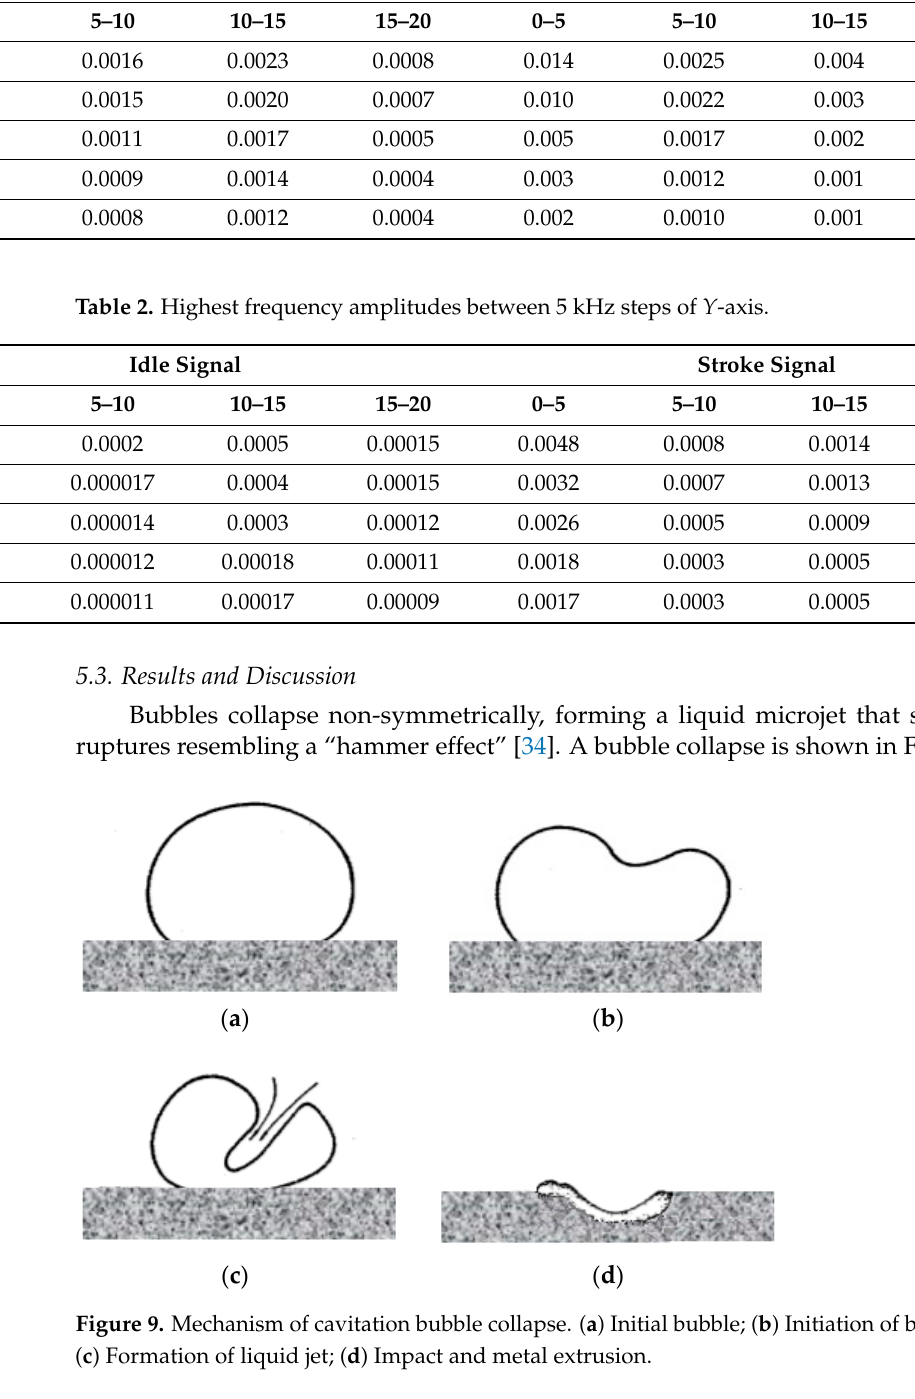
Table 1. Highest frequency amplitudes between 5 kHz steps of X-axis.